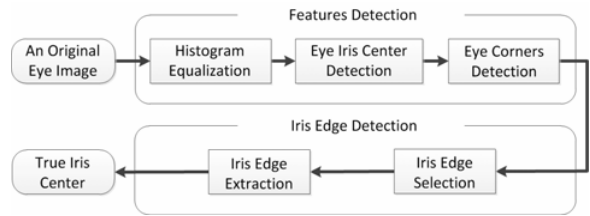
Figure 2: The procedure of iris center detection method. The feature detection starts from an original eye im- rough iris center and two eye corners, respectively.